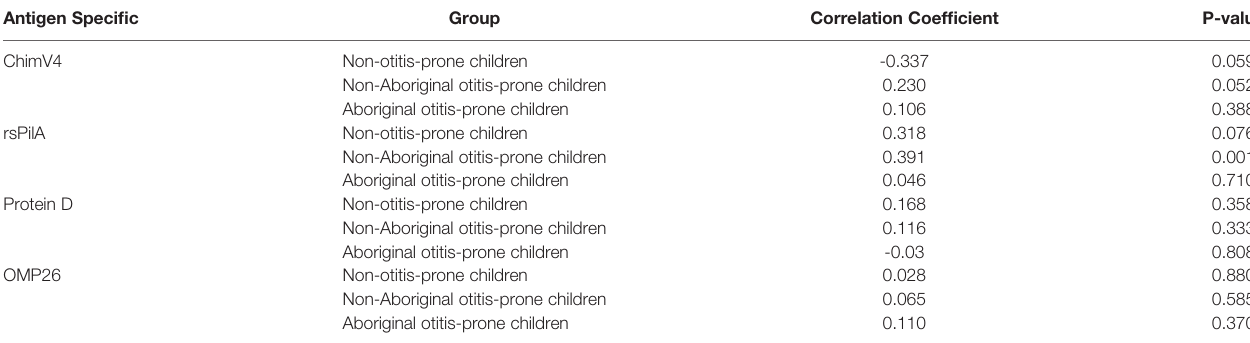
TABLE 3 | Correlation of antigen speci fi c IgG RAI with